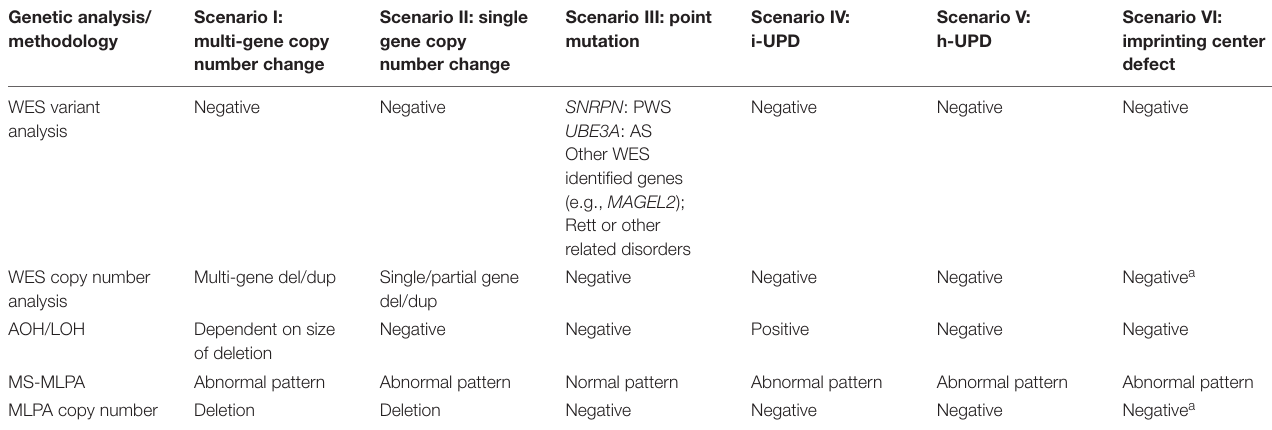
TABLE 2 | Known molecular mechanisms of PWS and AS and the expected results for the different analytical methods